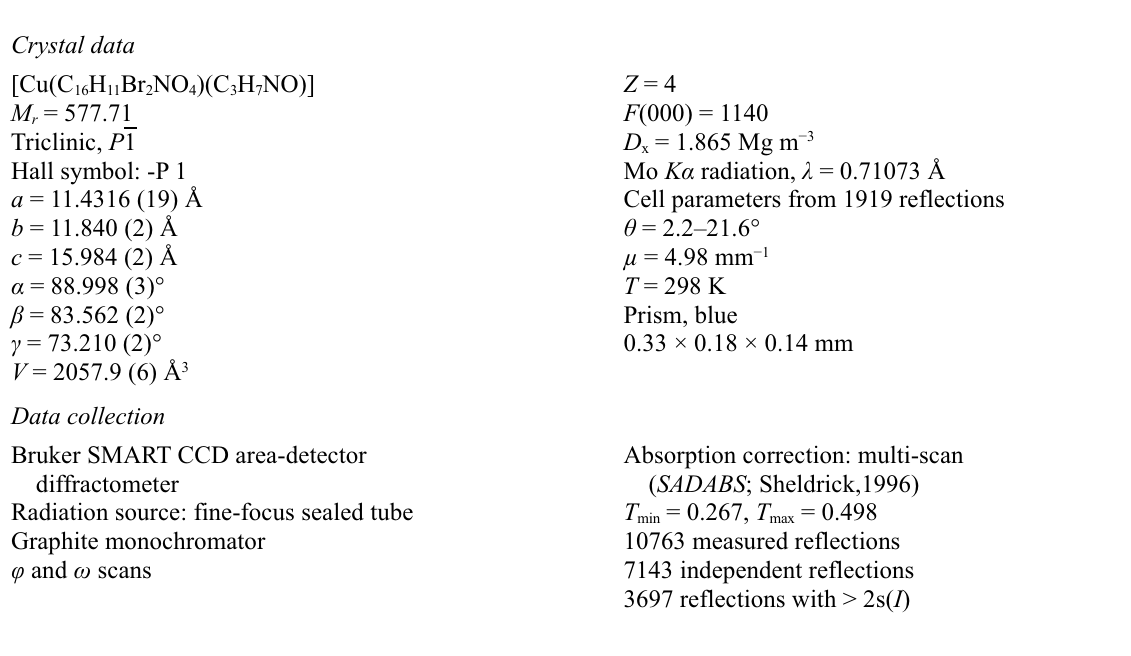
Crystal packing of (I) showing the three-dimensional network, with hydrogen bonds drawn as dashed lines. [( E )-2-(3,5-Dichloro-2-oxidobenzylideneamino)-3-(4- hydroxyphenyl)propionato- κ 3 O , N , O ′ ](dimethylformamide- κ O